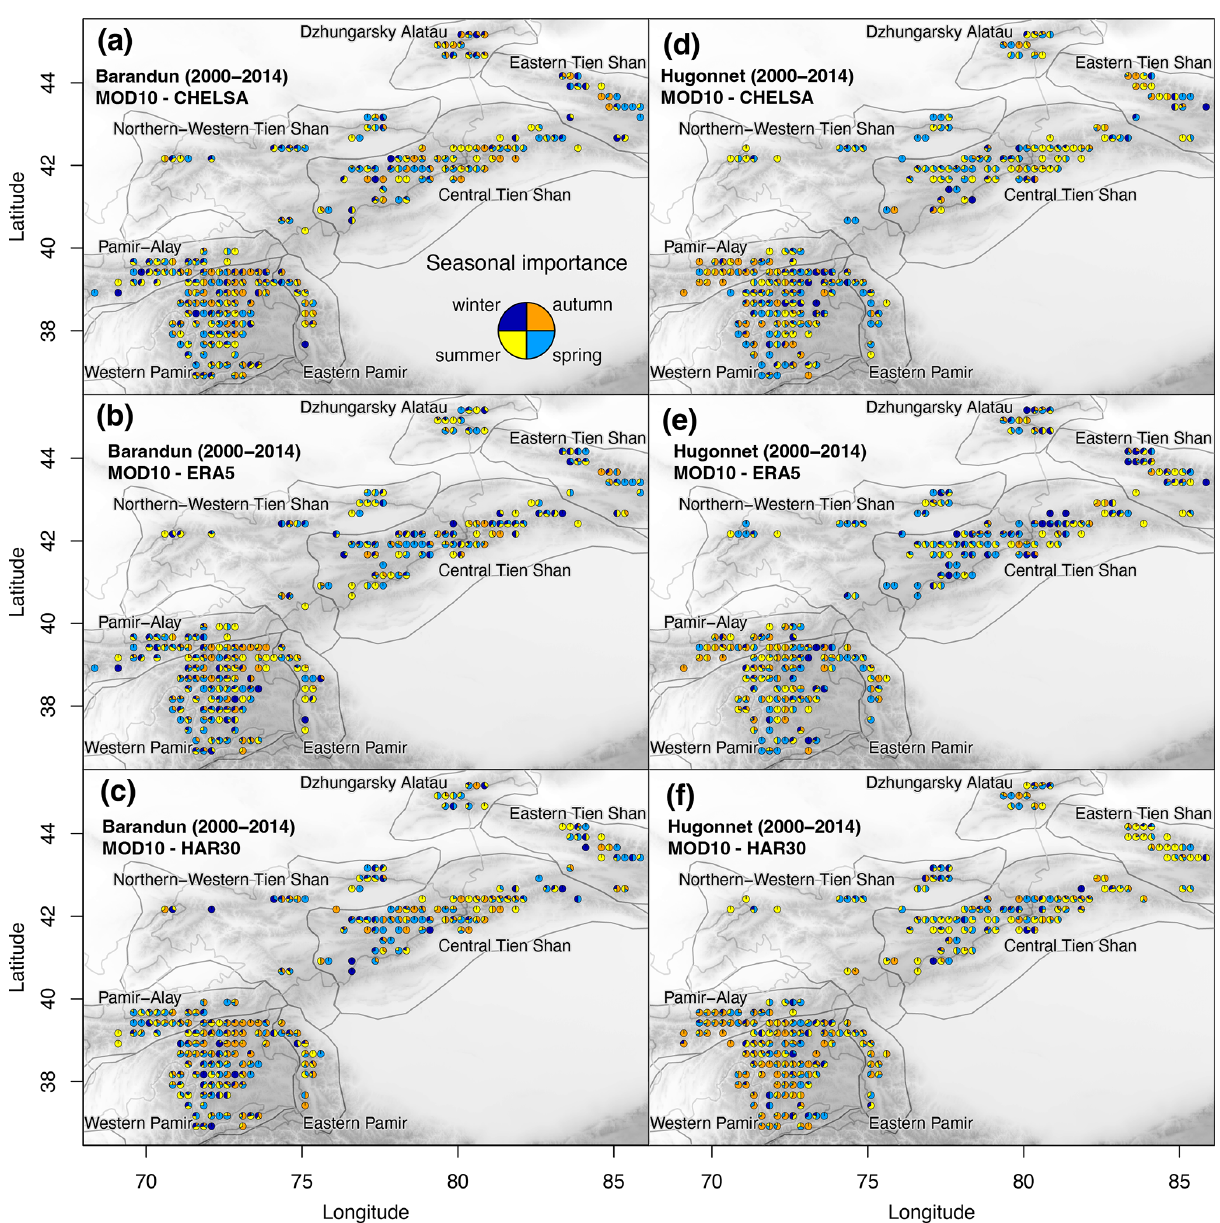
Figure 10. Seasonal importance from the temporal analysis between annual mass balance estimates from (a–c) Barandun et al. (2021a) and (d–f) Hugonnet et al. (2021) and two meteorological variables from the different reanalysis datasets; SC as indicated in the figure legends.